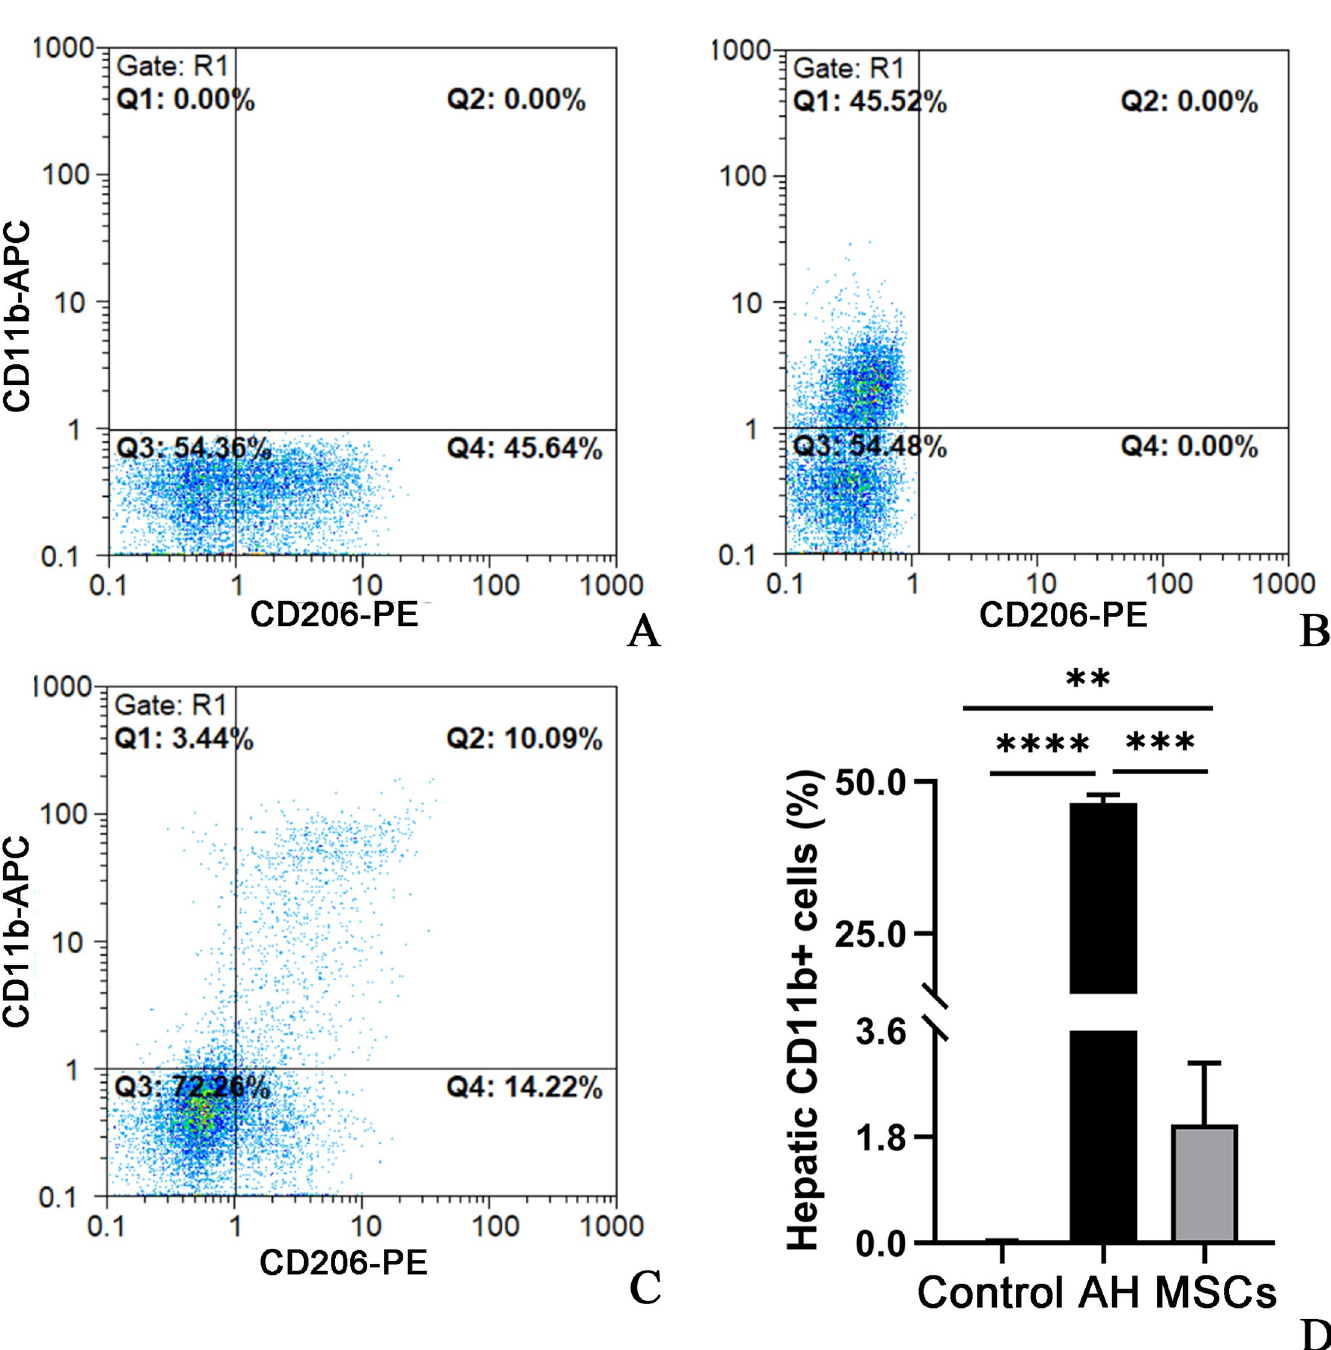
Fig 7. A-D MSCs decreased the percentage of macrophages (CD11b+) from the total isolated liver cells determined by flow cytometry: control (A), AH (B) and MSCs groups (C); statistical analysis (D). Four mice per group were used. � P < 0.05, �� P < 0.01, ��� P < 0.001. AH, alcoholic hepatitis; APC, allophycocyanin; MSCs, mesenchymal stem cells; PE,